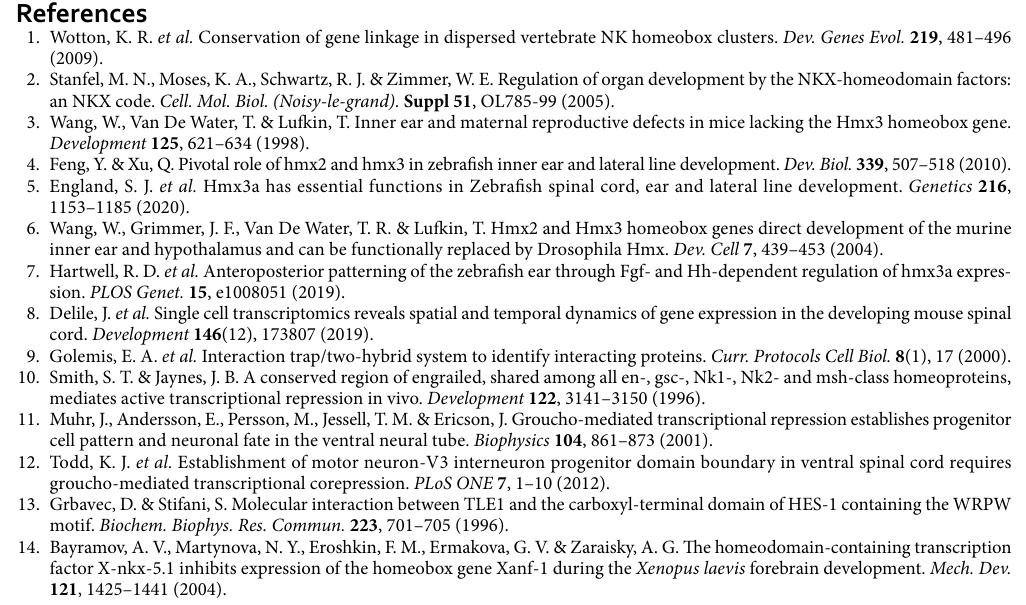
Fig. S1 panels a-f) or 1:1,000 monoclonal mouse GST antibody [Biotin], (A00867; Genscript) and 1:6,000 IRDye 800CW Streptavidin (925-32230; Licor) (Figs. 2, 3, Supplementary Fig. S1 panel g). FLAG-Hmx3a proteins were detected with 1:2,000 Monoclonal Anti-FLAG M2 antibody (F1804; Sigma-Aldrich) and either 1:15,000 IRDye 680RD Goat anti-Mouse IgG (925-68070) (Supplementary Fig. S1 panels a-f) or 1:15,000 IRDye 800CW Goat anti-Mouse IgG (925-32210; Licor) (Figs. 2, 3, Supplementary Fig. S1 panel g). Blots were imaged on a Licor Odyssey CLx Imaging System (Licor). Data